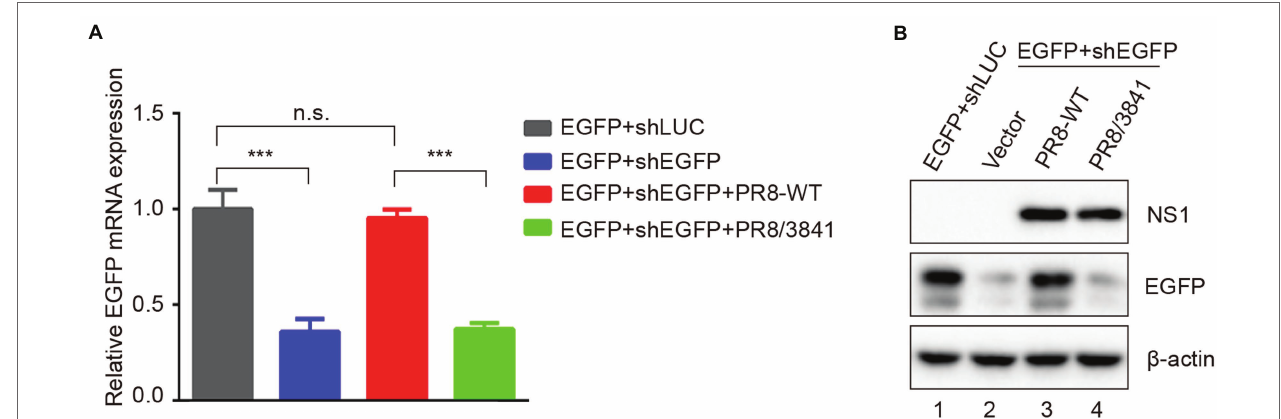
FIGURE 7 | R38A-K41A substitutions in NS1 abolish the inhibition of shRNA-mediated RNAi. (A) Relative mRNA levels of EGFP as quantified by qRT-PCR. 293 T cells were co-transfected with a plasmid encoding EGFP and EGFP-specific shRNA (shEGFP) or luciferase-specific shRNA (shLUC) as a negative control and then infected with PR8-WT (MOI = 1) or PR8/3841 (MOI = 1). After 48 h post-transfection, total RNAs were extracted, and the level of EGFP mRNA was examined by qRT-PCR. The experiments were repeated three times independently. The mRNA level of EGFP+shLUC group was set as 1. *** p < 0.001 (Student’s t-test). ns indicates no significance. (B) Western blotting detection of EGFP, NS1, and β -actin